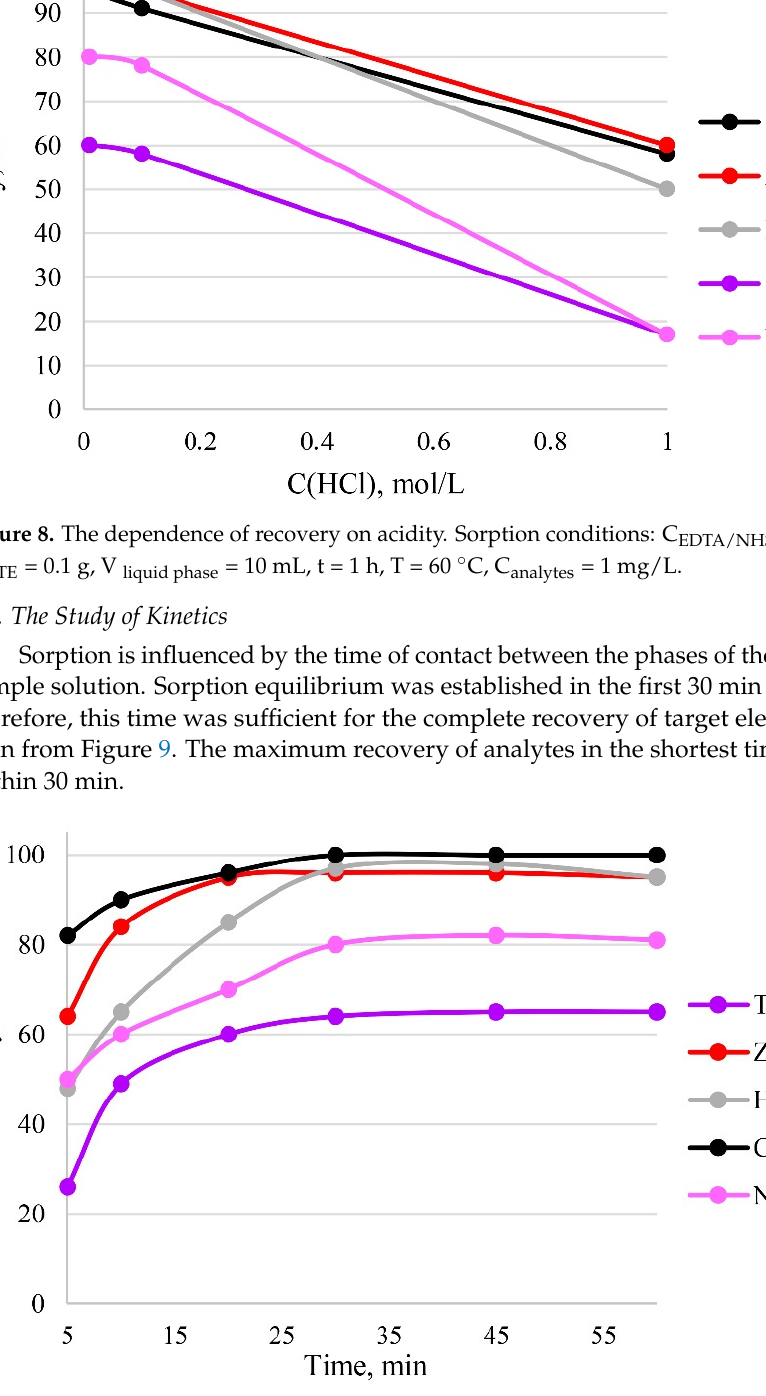
Figure 9. The dependence of recovery on time. Sorption conditions: 0.1 mol/L HCl, C EDTA/NH3 = 50/2500 mg/L, m PTE = 0.1 g, V liquid phase = 10 mL, T = 60 °C, c analytes = 1 mg/L.